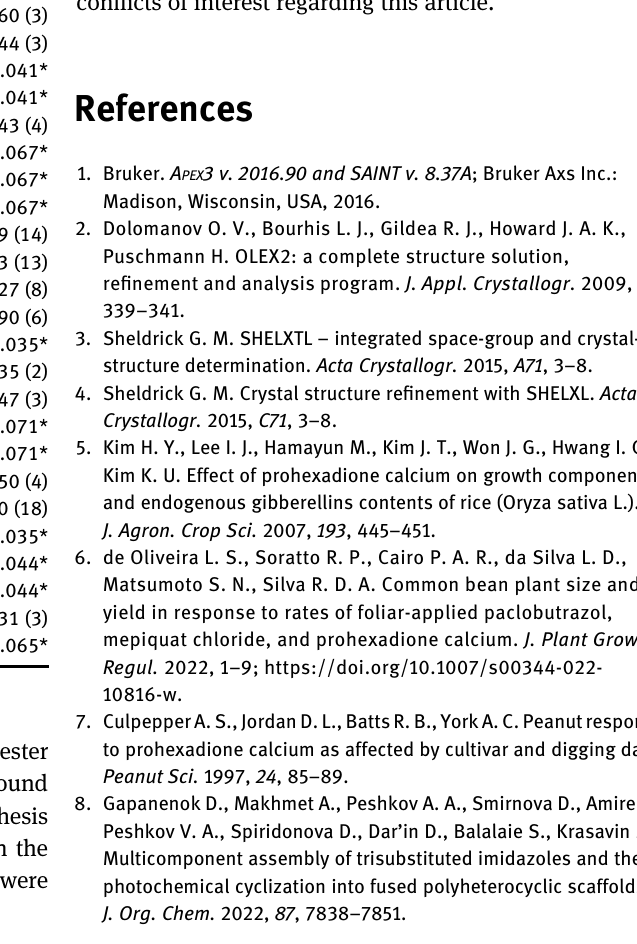
The basic structural unit of the crystalline form of prohexadione hydrate consists of one molecule of cyclic acid and one molecule of water (see the figure). The O1 atom on the carboxyl group of the prohexadione molecule is the hydrogen bond acceptor and the H6 atom on the water molecule is the hydrogen bond donor, forming